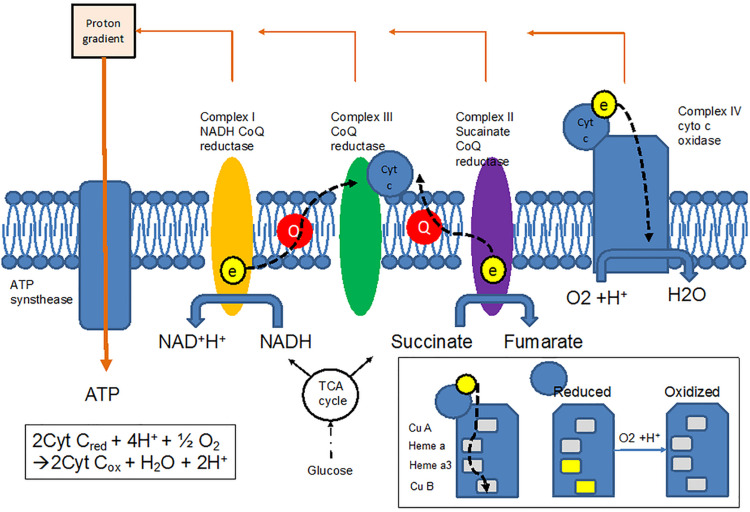
Electron transfer chain allows electrons to be transferred from the TCA cycle to oxygen via cytochrome c oxidase (CCO), resulting in changes in the redox states of CCO.